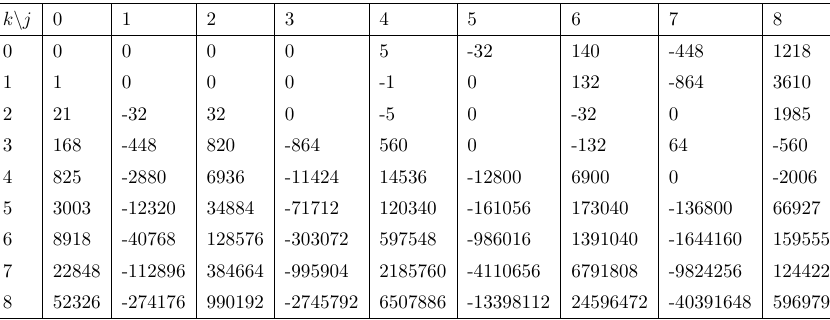
Table 64. Table of b jk coe(cid:14)cients for h SO(7)